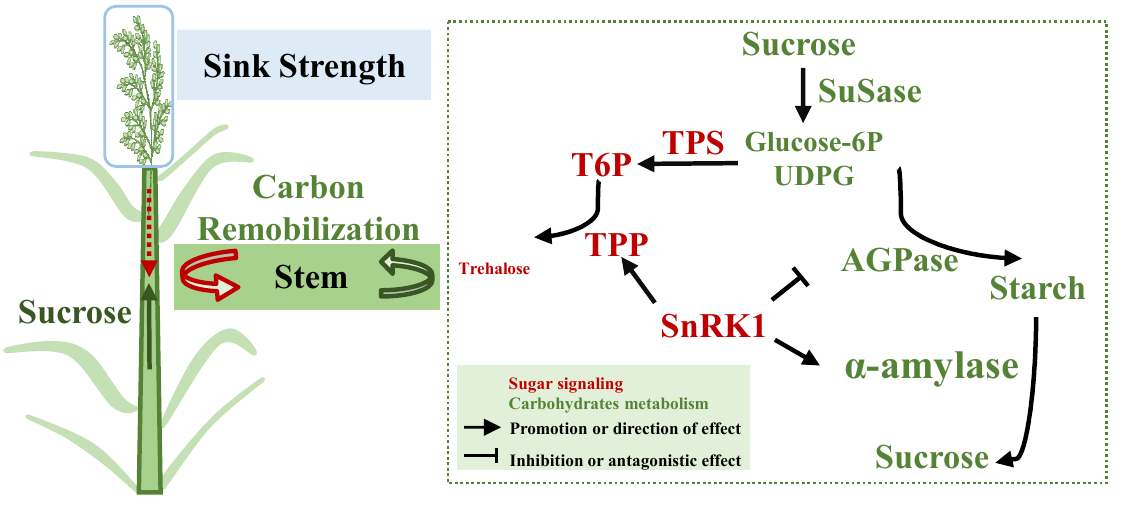
Figure 6. Model of metabolism and transportation of carbon in stem of rice during grain filling. Solid arrows direction effects; broken line indicates the indirection of effect; different colors indicate various metabolism.